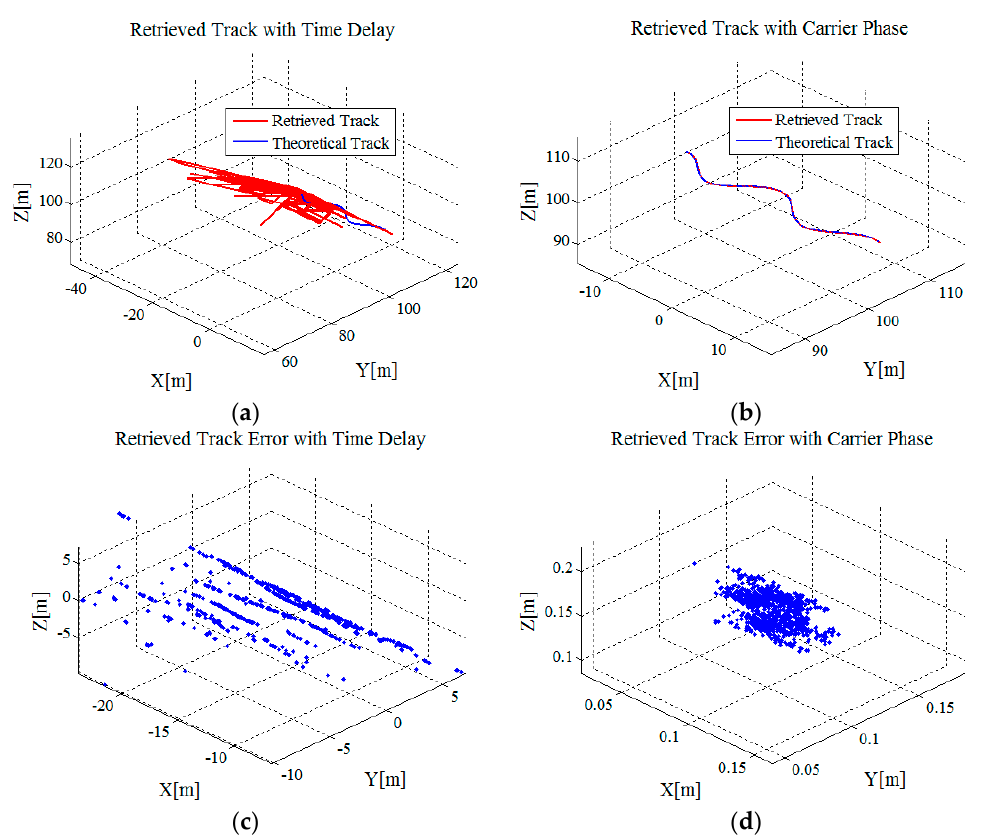
Figure 5. Measurement results: ( a ) Retrieved result of the target’s 3-D track with range information derived from the time delay; ( b ) retrieved result of the target’s 3-D track with range information derived from the carrier phase; ( c ) retrieved error of the target’s 3-D track with range information derived from the time delay; and ( d ) retrieved error of the target’s 3-D track with range information derived from the carrier phase.